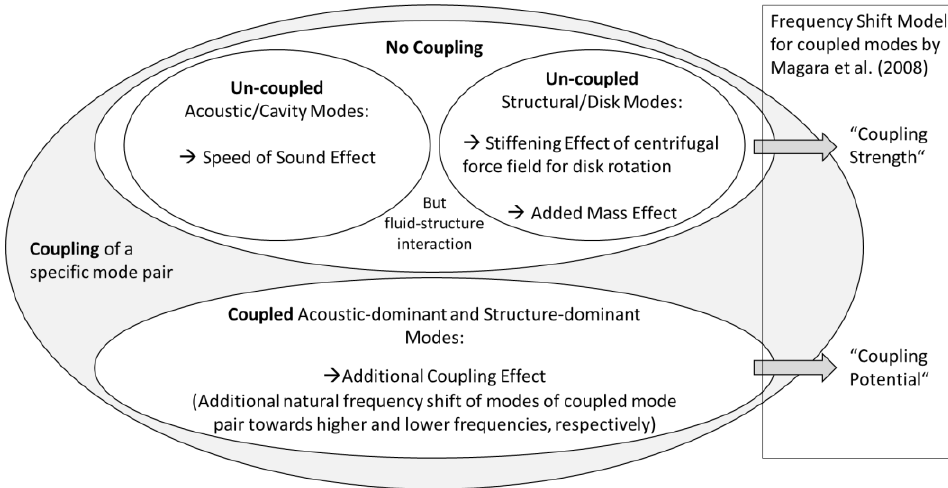
Figure 3. Overview of frequency shift effects in rotor-cavity systems [12].